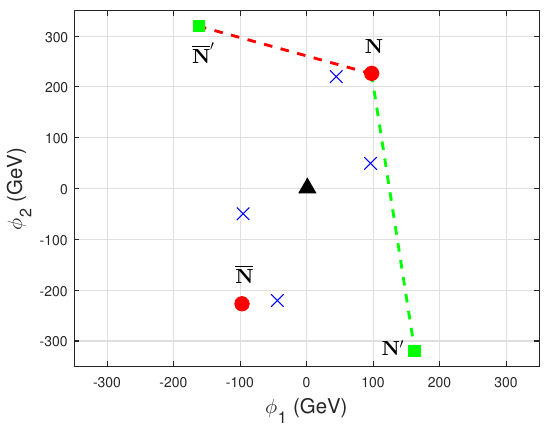
Figure 2 . Location of all extrema of the 2HDM potential for the choice of parameters in (5.1). Saddle points are marked with \ (cid:2) ", the maximum of the potential, at (0 ; 0), with a black triangle. The false minima are marked with red circles, the true ones with green squares. The lines connecting N to N 0 and N 0 illustrate how di(cid:11)erent the paths between these minima may be.